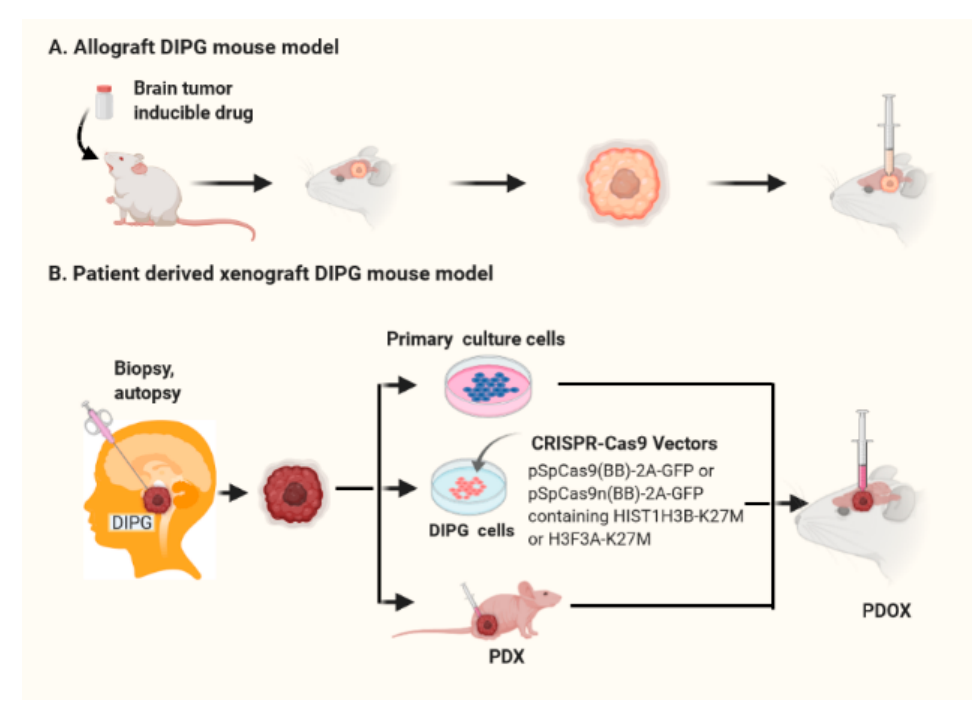
Figure 2. Schematic diagrams illustrate the development mouse models for DIPG. ( A ) Allograft mouse models. ( B ) Patient derived xenograft (PDX) or patient derived orthotopic xenograft (PDOX) mouse models using primary culture cells with or without modification using CRISPR-Cas9 gene editing, and viable tumor biopsy or autopsy